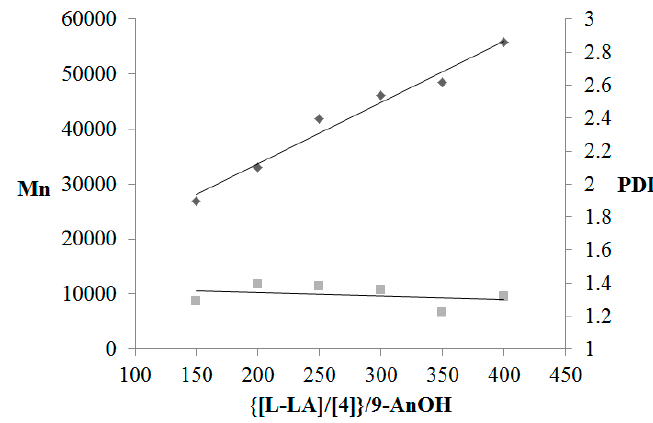
Figure 2. Polymerization of L -LA catalyzed by 4 in toluene at 30 °C (PDI = M w/ M n in Table 3).